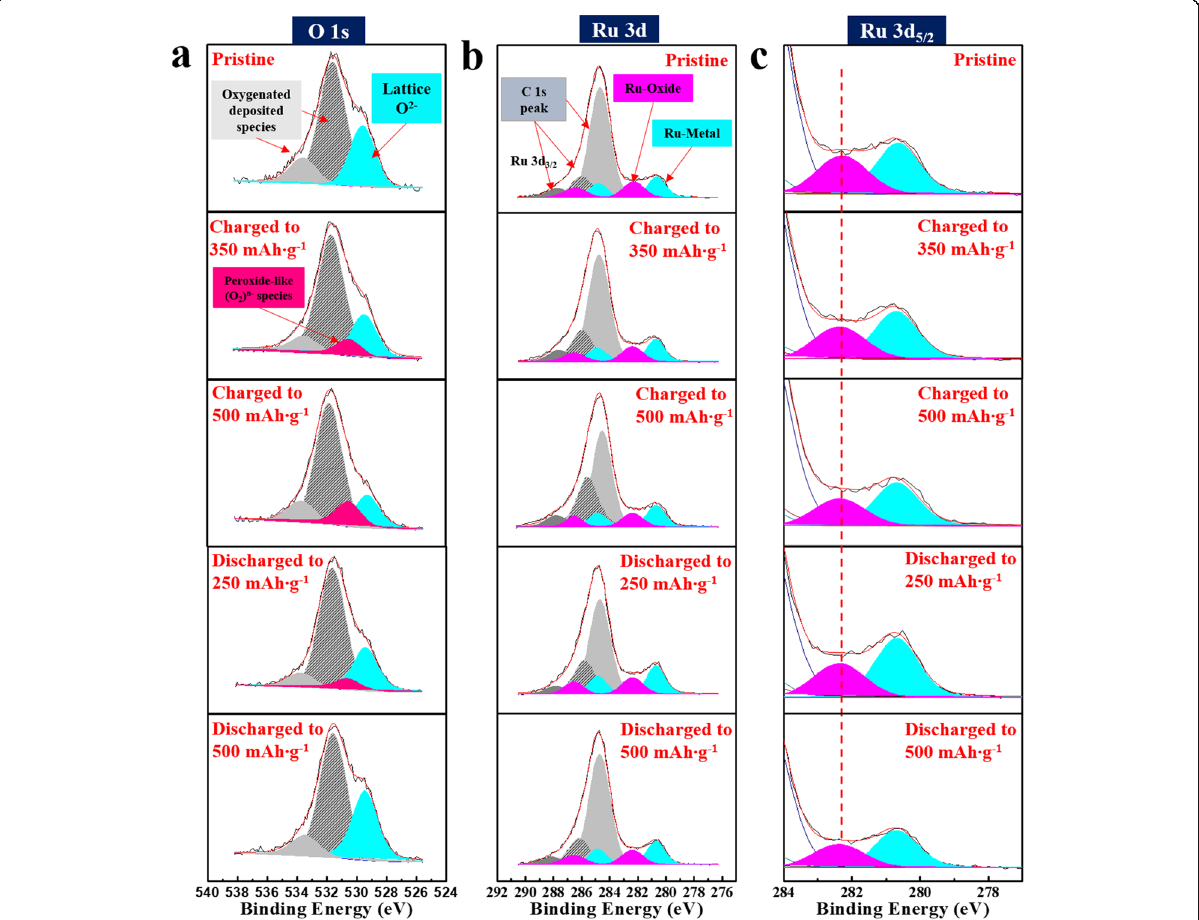
Fig. 6 XPS spectra of the lithia/Li 2 RuO 3 nanocomposites measured at various charging and discharging points. For the measurement, the nanocomposites were charged to 350 and 500 mAh g − 1 (assigned as full charge), and discharged to 250 and 500 mAh g − 1 after full charge. a O 1 s spectra, b Ru 3d spectra, and c Ru 3d 5/2